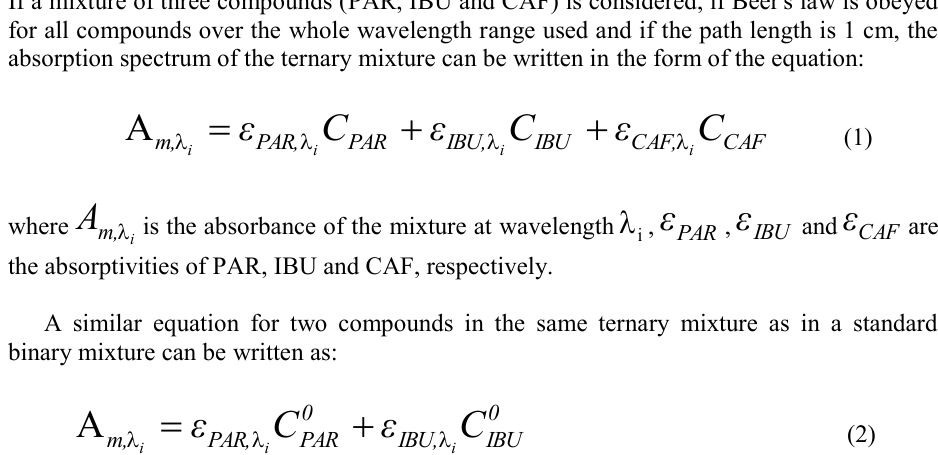
Double divisor ratio spectra derivative